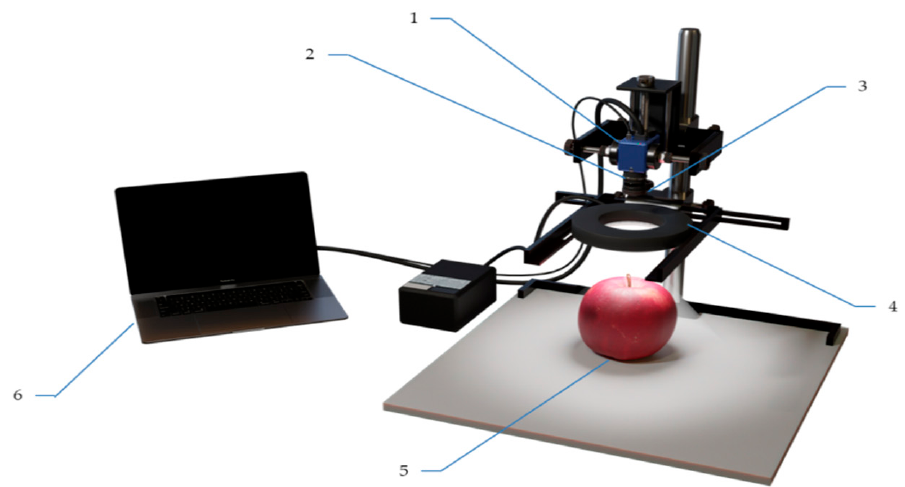
Figure 1. Multi-band image acquisition system: (1) near-infrared industrial camera, (2) C-mount lens, (3) optical filters, (4) ring light source with adjustable light intensity, (5) apple, (6)